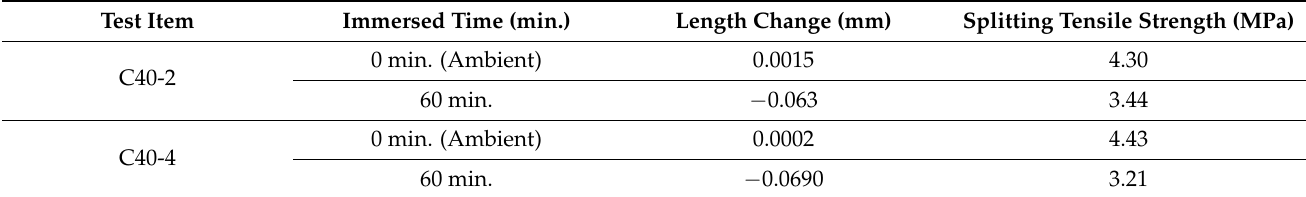
Table 12. Test results of length change and splitting tensile